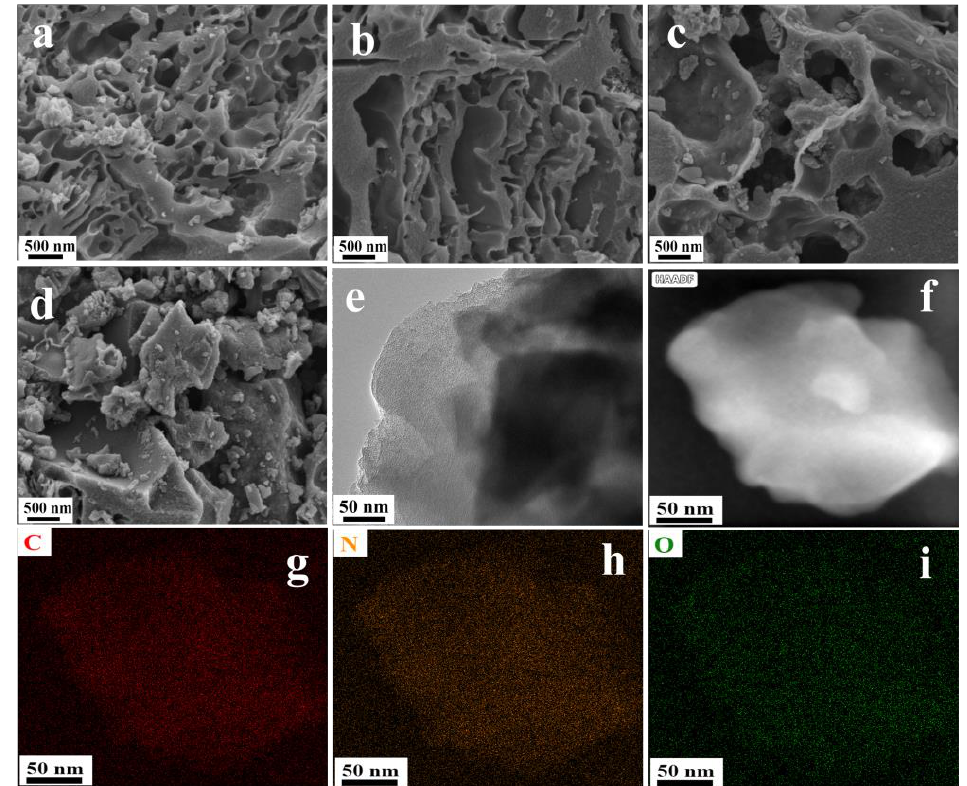
Figure 2. SEM image of D-GH catalysts; ( a – d ) stands for D-GH-600, D-GH-800, D-GH-1000, and D- GH-1200, respectively. ( e ) TEM image of D-GH-800 catalyst. ( f – i ) HAADF-STEM mapping (C, N, and O) of D-GH-800. Table 1. Pore structure parameters and element content of various